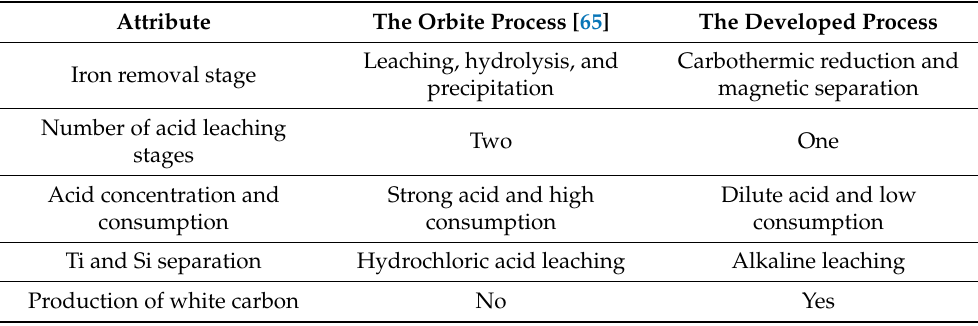
Table 11. The main differences between Orbite and the developed process in this study to treat bauxite